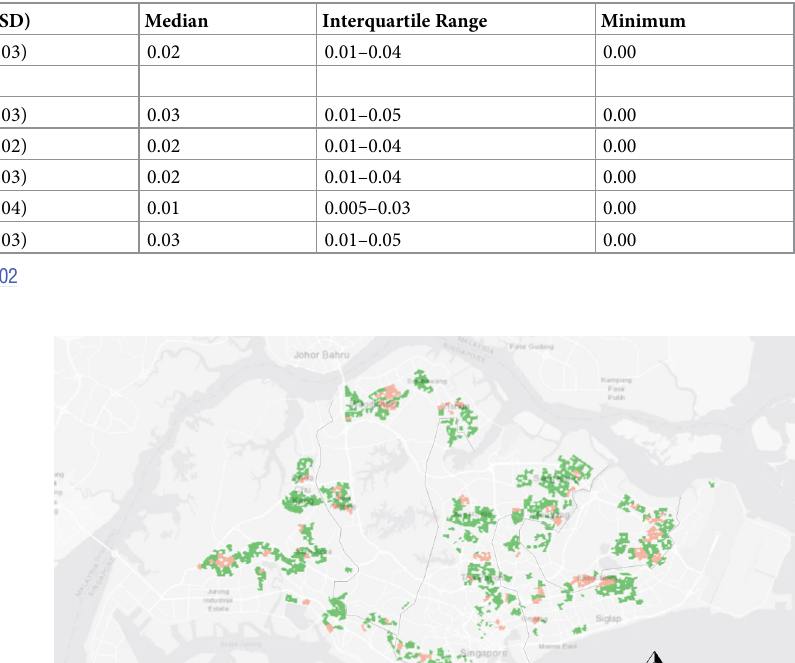
Table 2. Summary statistics of the mean Ae . albopictus trap rates, GI albo . Interquartile range refers to the 1 st and 3 rd quartile.